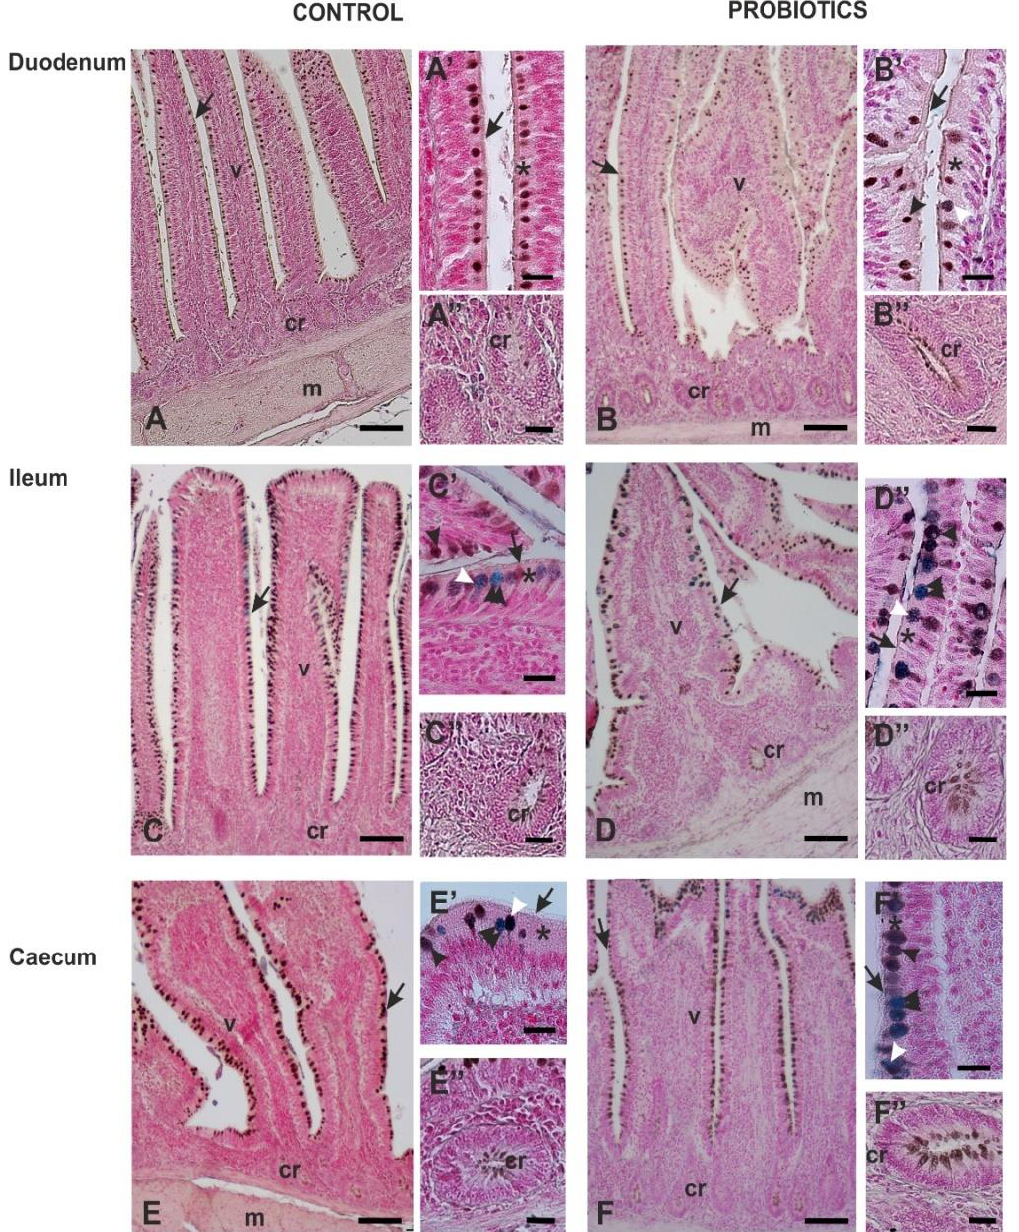
Figure 4. HID/AB2.5 staining sequence of guineafowl duodenum ( A , B ), ileum ( C , D ) and caecum ( E , F ). A,C,E: C samples; B,D,F: P samples. Most of the goblet cells exhibit HID positivity (brown), whereas few goblet cells are either only AB2.5- positive (blue) or both HID- and AB2.5-positive. cr, crypt; m, muscularis wall; v, villus; arrow, villus luminal surface; asterisk, epithelial cells. Black arrowhead, HID-positive goblet cells; double arrowhead, AB2.5-positive goblet cells; white arrowhead, mixed stained goblet cells. Scale bars: A–F, 100 µ m. A’–F’ and A”–F”, 20 µ